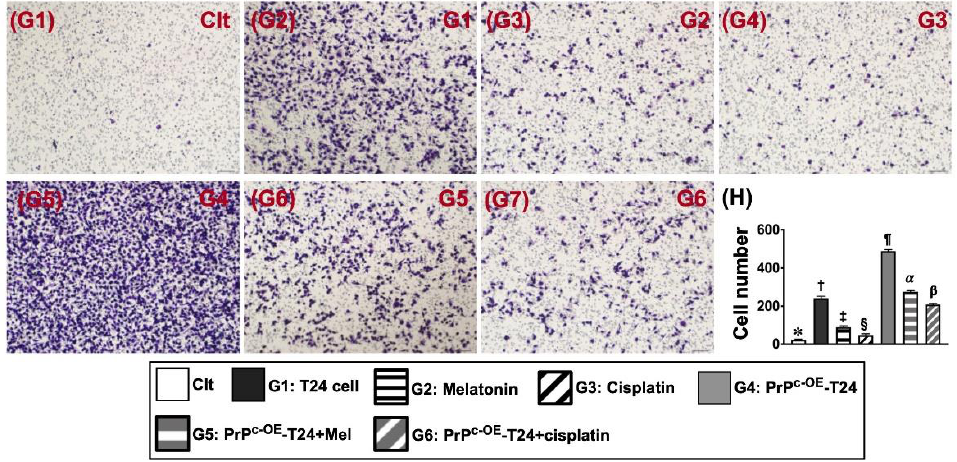
Figure 3. Migratory ability of T24 cells in different conditions. ( G1 – G7 ) Showing the microscopic findings (100 × ) for identifying the migratory T24 cells (gray color). ( H ) Analysis of the number of migratory cells, * vs. different symbols (†, ‡, §, ¶, α , and β ), p < 0.0001. n = 5 for each group. Control (Clt) = V-HUC-1; G1 = T24 only; G2 = melatonin (Mel); G3 = cisplatin; G4 = PrP C overexpression in T24 cells (i.e., PrP C-OE -T24); G5 = PrP C-OE -T24 cells + Mel (100 µ M treated for 24 h); G6 = PrP C-OE -T24 cells + cisplatin (6.0 uM treated for 24 h).